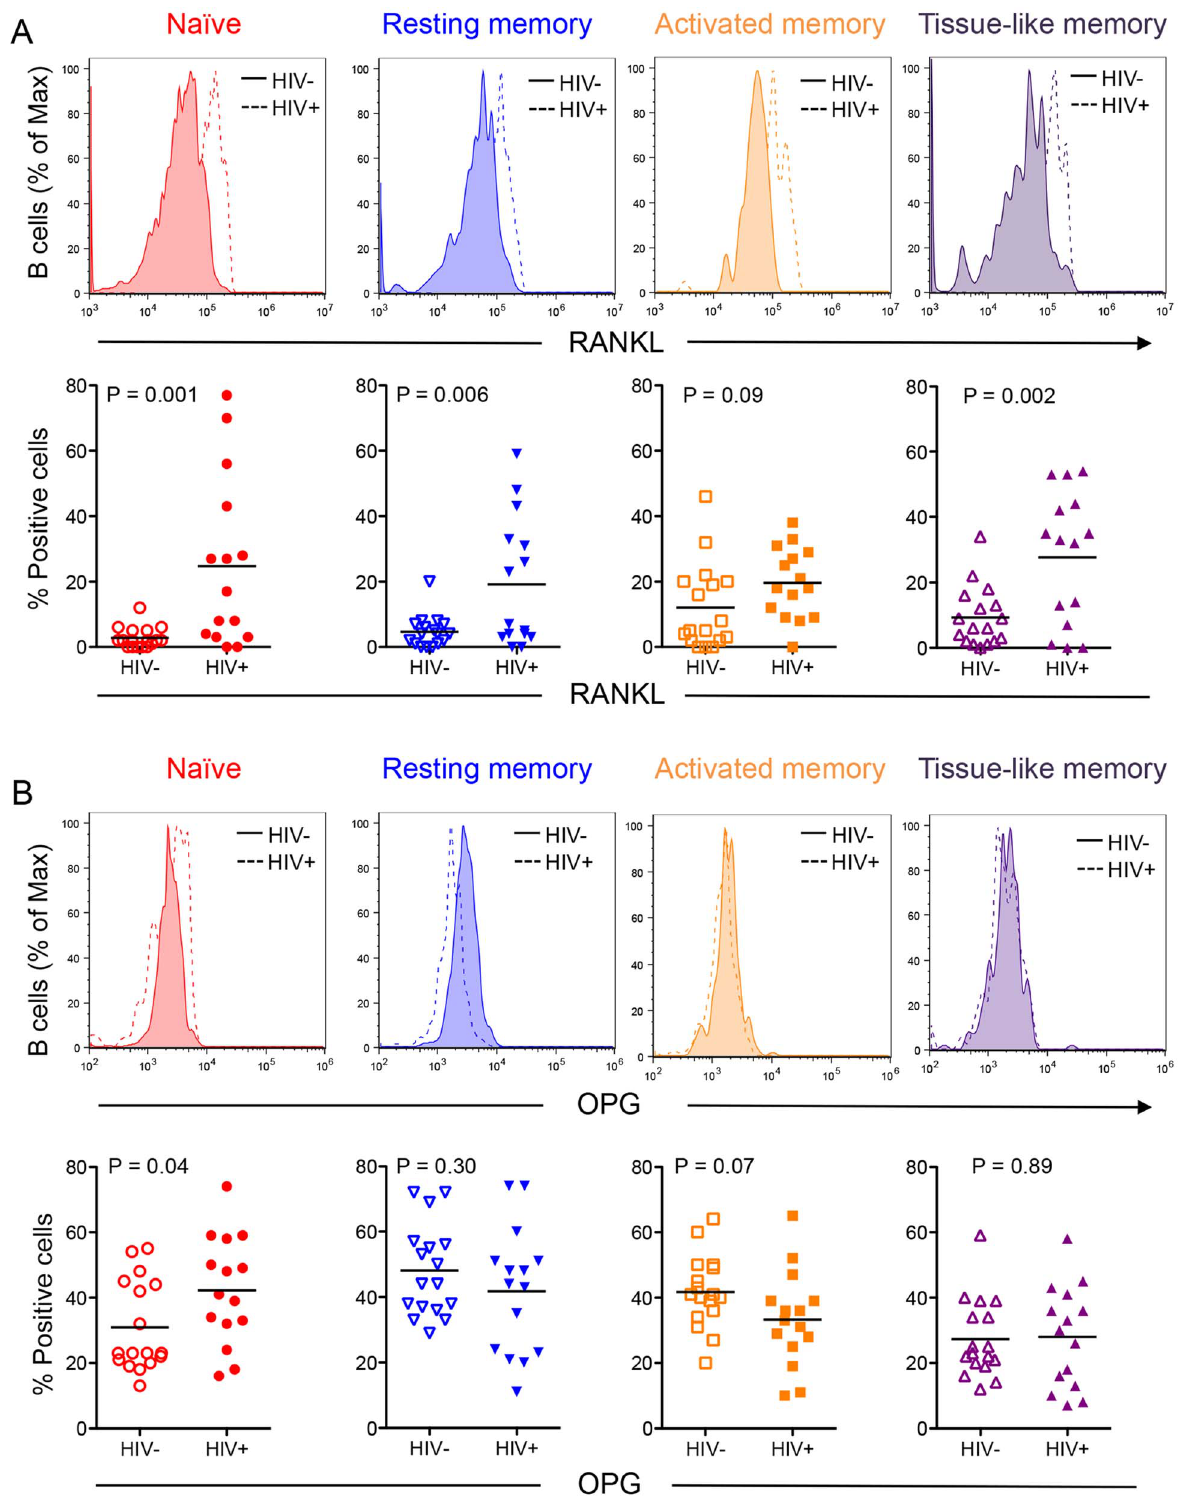
Figure 3. Differential B cell subset RANKL and OPG expression in HIV-negative and HIV-positive individuals. Representative histograms (alternate top panels) of B cell subset staining for RANKL ( A ) and OPG ( B ) for HIV negative individuals (solid line) and HIV positive individuals (dashed line). Scatter plots (alternate bottom panels) represent cumulative data for B cell subset RANKL ( A ) or OPG ( B ) expression from individual HIV-negative (HIV 2 , N=17) or seropositive (HIV + , N=15) individuals with bars at the mean (parametric data) or median [non-parametric data, RANKL: tissue-like memory (HIV-); OPG: All HIV- subsets]. Comparisons were done using two-way ANOVA, followed by pairwise comparisons of individual B cell subsets using student’s t-test (parametric data) or Wilcoxon rank sum test (non-parametric data).